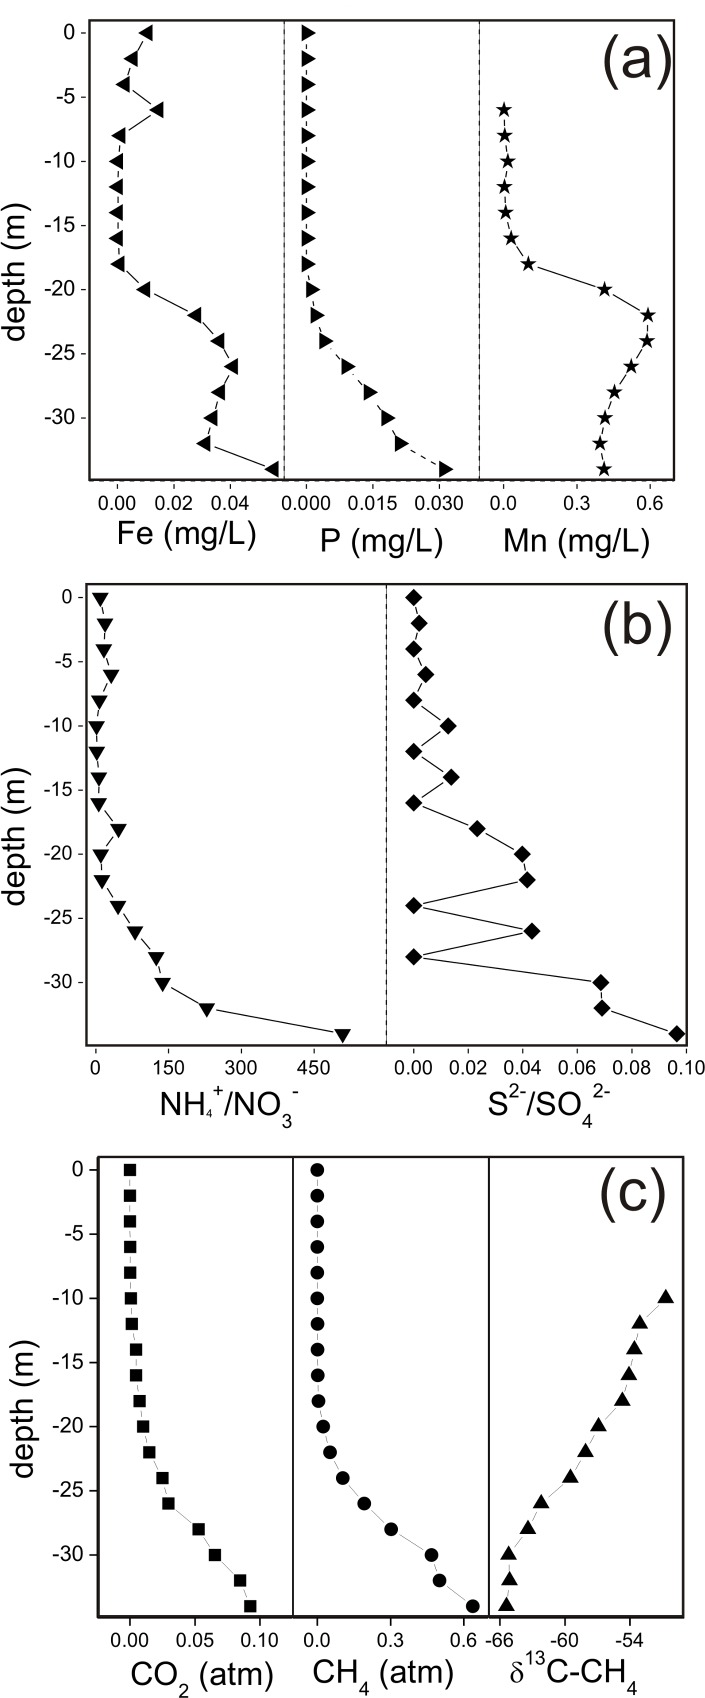
Vertical profiles along the Lake Averno water column of (a) P, Fe and Mn concentrations, (b) ΣS2-/SO42- and NH4+/NO3- ratios, and (c) δ13C-CH4 values (‰ vs. V-PDB) and CO2 and CH4 partial pressures (atm).